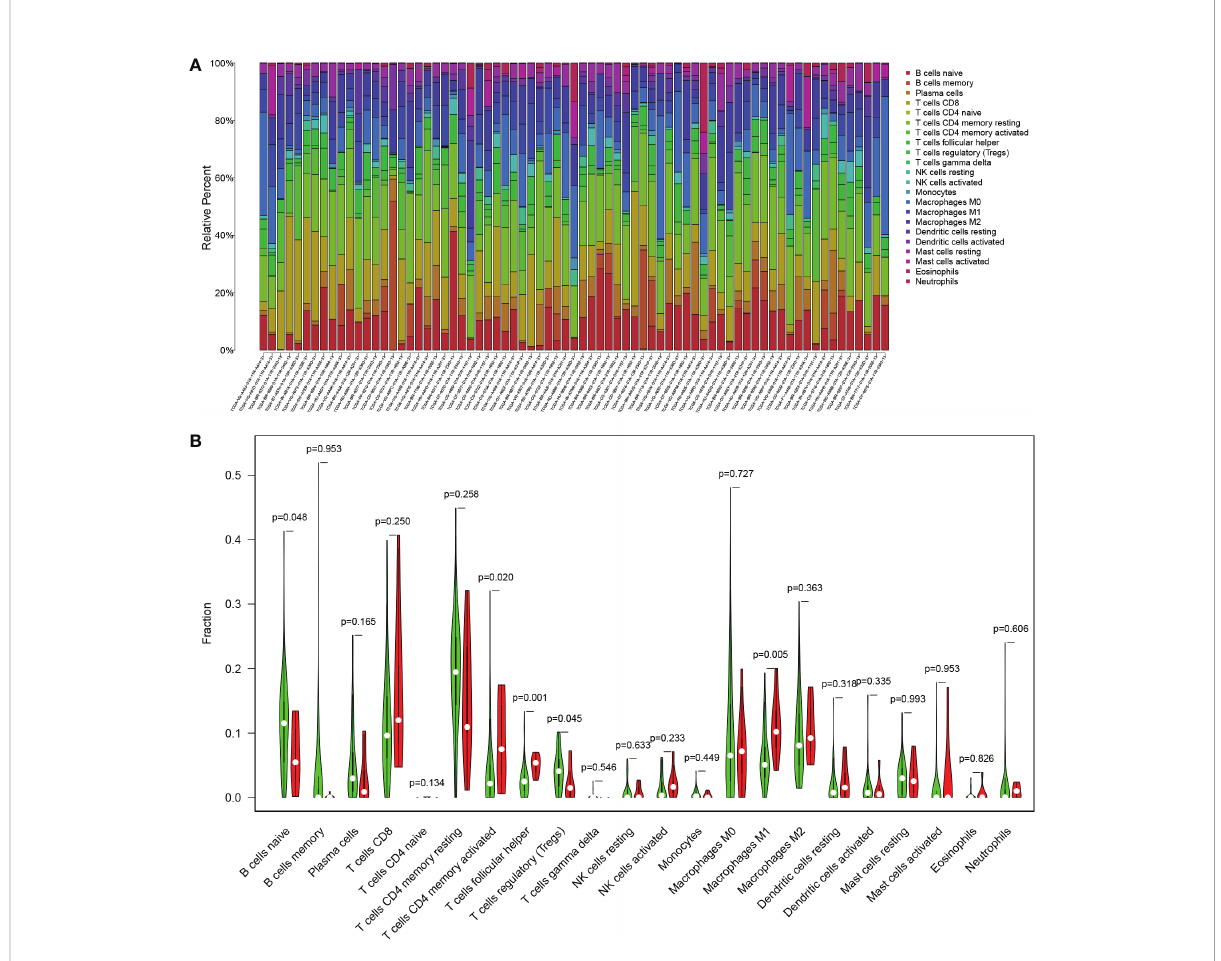
FIGURE 6 The immune cell in fi ltration related to TMB status in the TCGA cohort. (A) Proportion of 22 in fi ltrating immune cells in each sample. (B) Difference of in fi ltrating immune cells between the TMB-high (red) and the TMB-low (green)